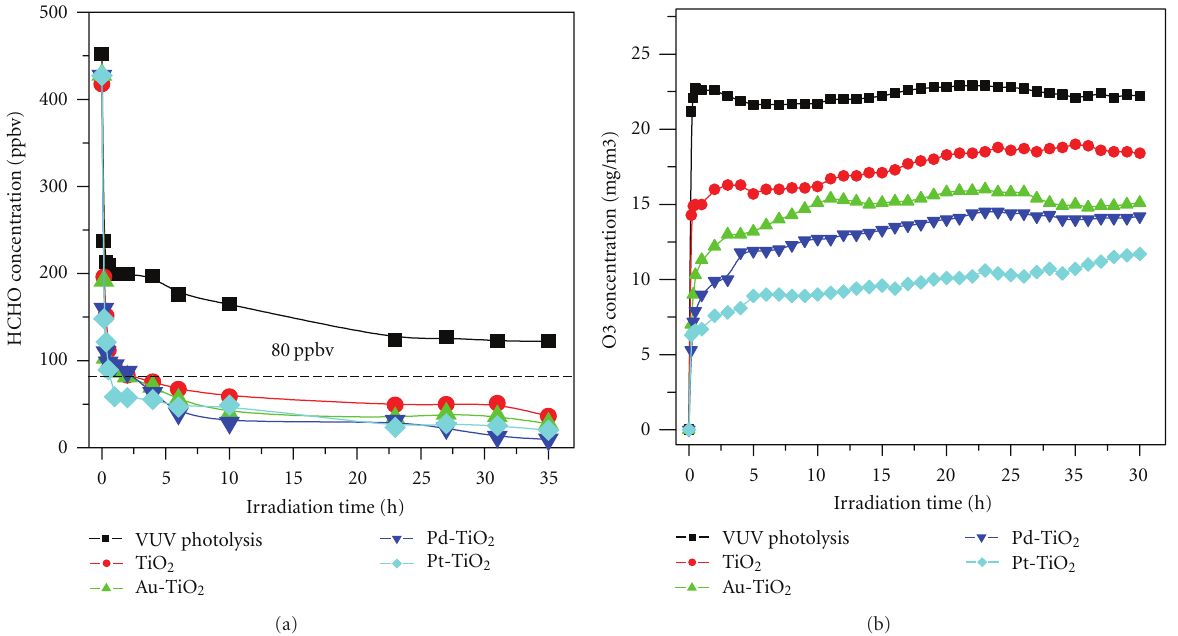
Figure 3: Time courses for the outlet concentration of HCHO (a) and ozone byproduct (b) with irradiation time in the 35 h VUV photocatalysis. The VUV photolysis is the VUV photochemical process without the photocatalyst.